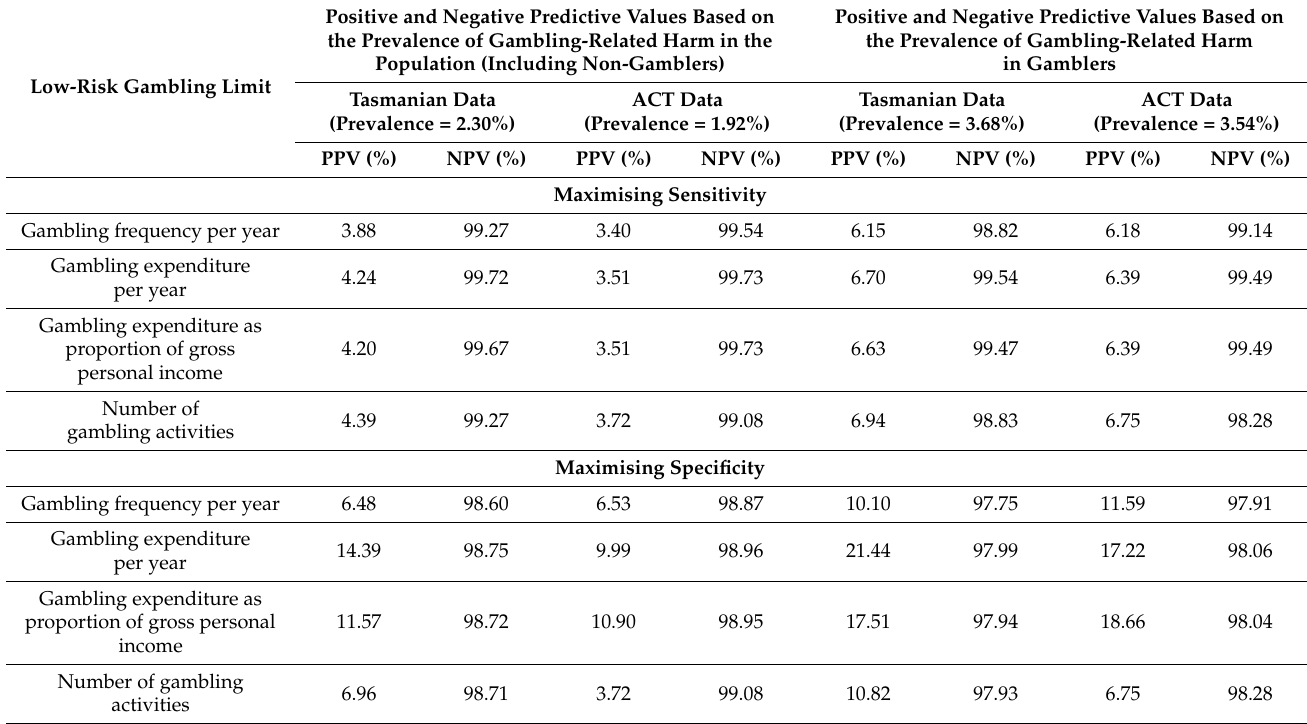
Table 7. Positive and negative predictive values based on the prevalence of gambling-related harm in the population and gambling samples after maximising sensitivity and specificity a,b